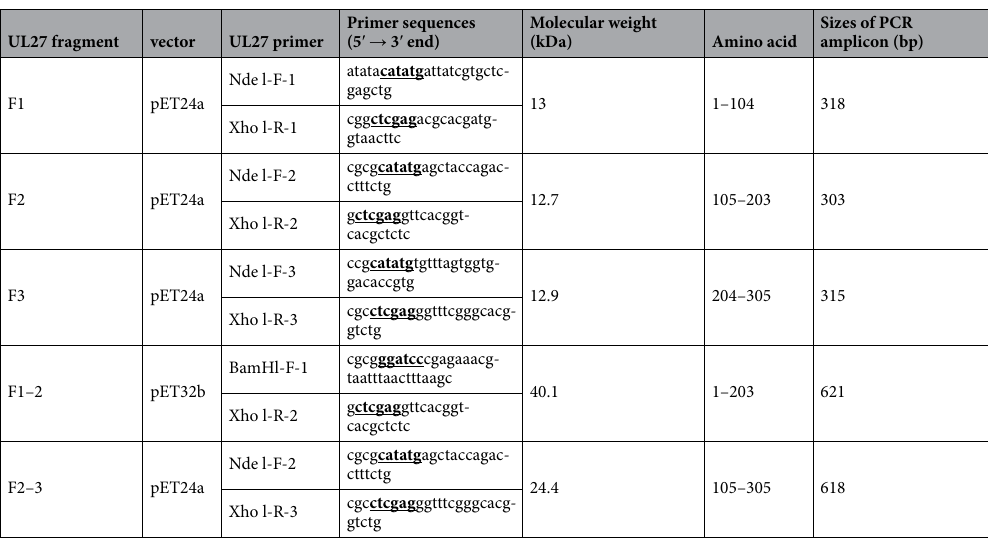
Table 1. Information on the constructs expressing the UL27 fragments. The bold characters indicate sequences recognized by restriction enzymes for the ease of further cloning